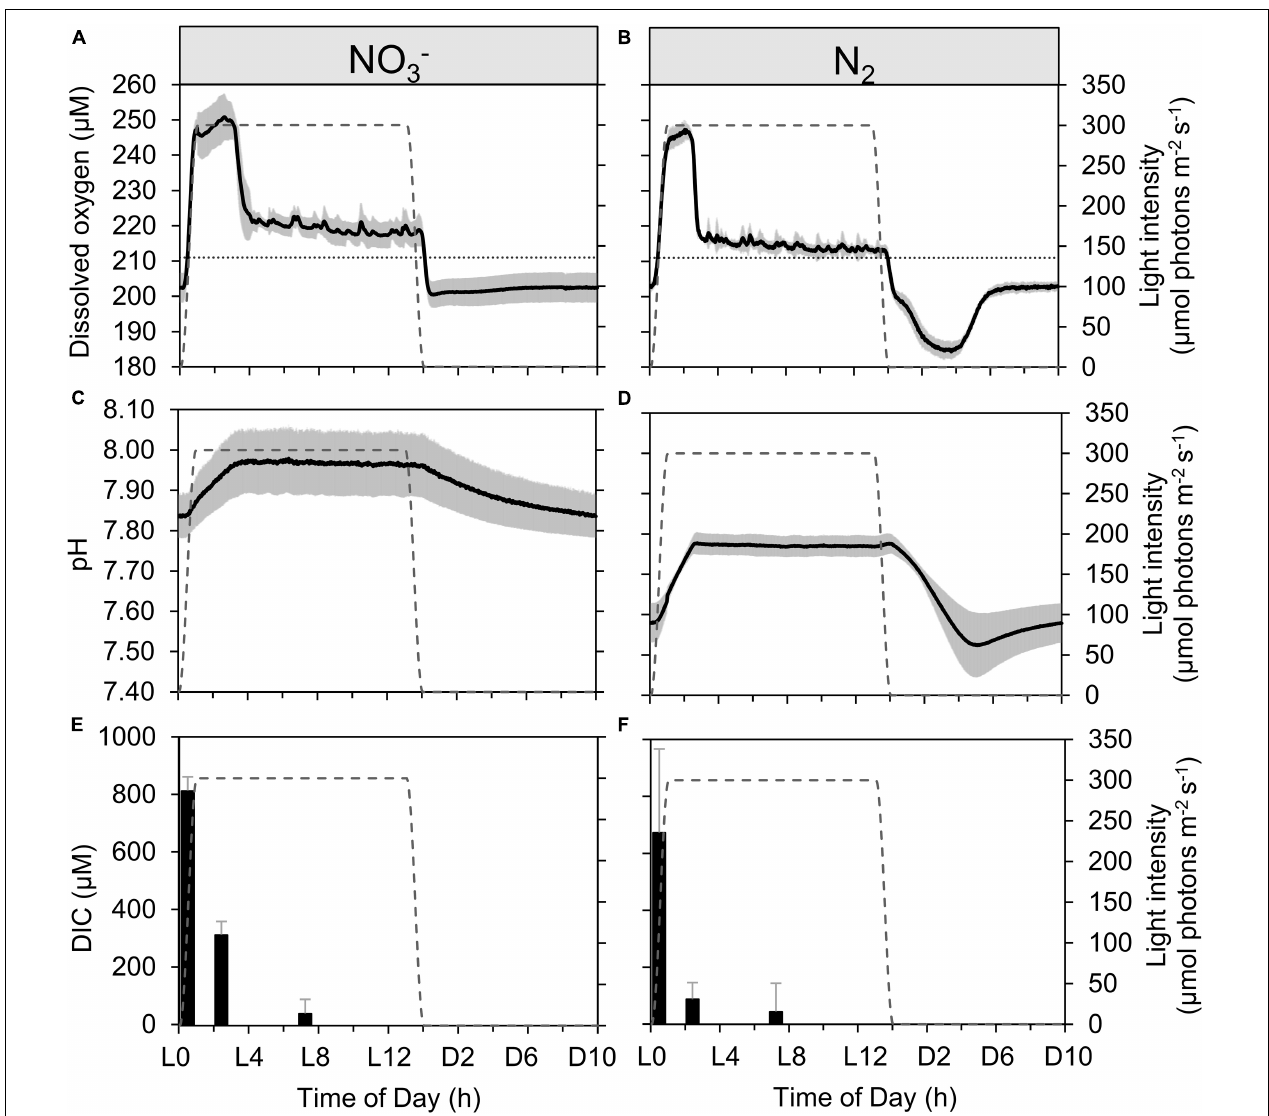
FIGURE 2 | Dynamics of dissolved oxygen (A,B) , pH (C,D) , and dissolved inorganic carbon [DIC, (E,F) ] in continuous Cyanothece cultures grown in ASP 2 medium either supplemented with NO 3 − (A,C,E) or not (B,D,F) , throughout the daily 14h/10h light/dark cycle. Each trace represents averages of 5–6 light/dark cycles of 2 (A–D) or 3 (E) (with the exception of L3 sample with n = 2), (F) independent cultures, with error intervals and bars, respectively (representing standard deviations). The dotted lines in panels (A,B) represent the level of O 2 equilibrium at 28 ◦ C in the medium, while the gray dashed line in each panel represents the light profile throughout the